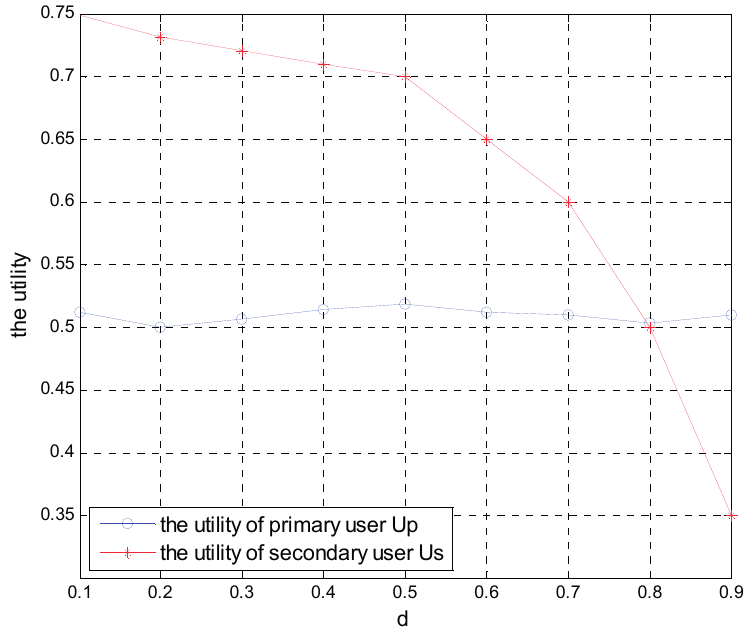
Figure 6. The primary user’s utility function of different schemes, where U P denotes the utility function of the proposed active-cooperation scheme, U 0 denotes the primary user’s utility function where all the bandwidth is given to secondary users, and U d denotes the utility function all the bandwidth is only used to transmit the primary user’ own data without cooperating with secondary users.